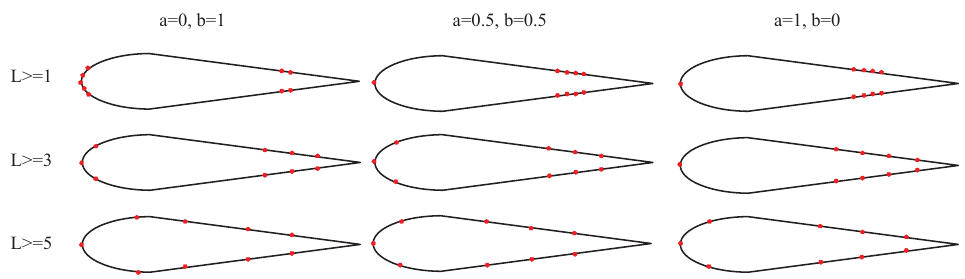
Figure 5. Change three parameters A,B,L, and obtain different sensor